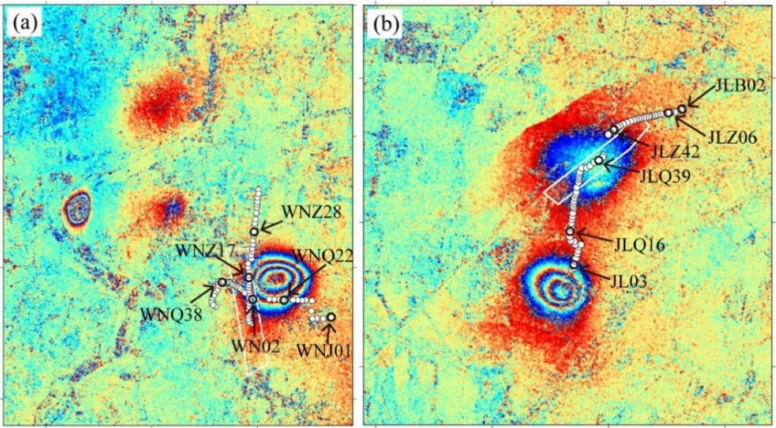
Figure 13. The distribution of the leveling stations marked with white dots of the ( a ) Wannian site and ( b ) Jiulong site. The background is one of the wrapped TerraSAR–X